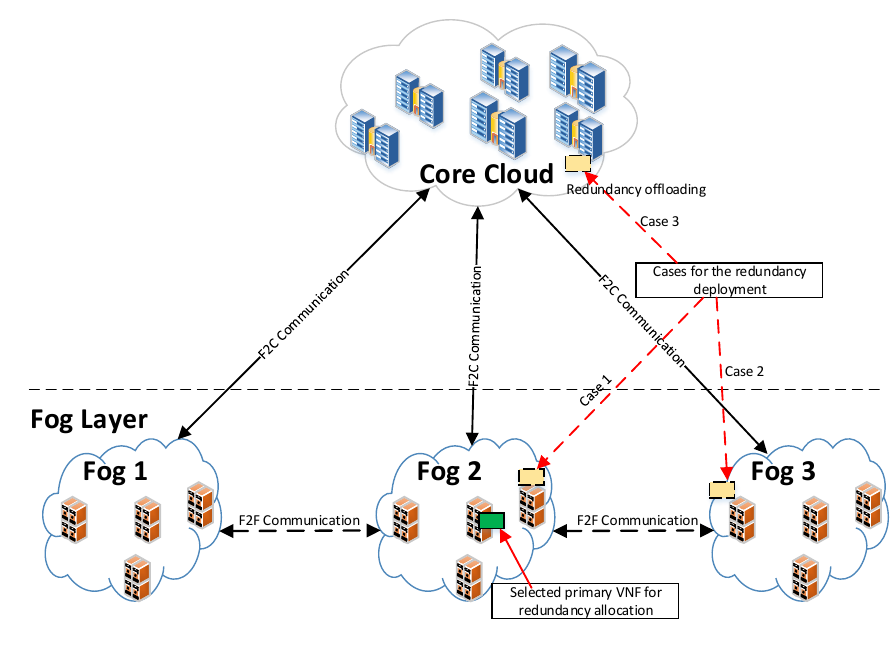
Figure 2. Scenarios for the redundancy deployment of the primary VNF at the fog